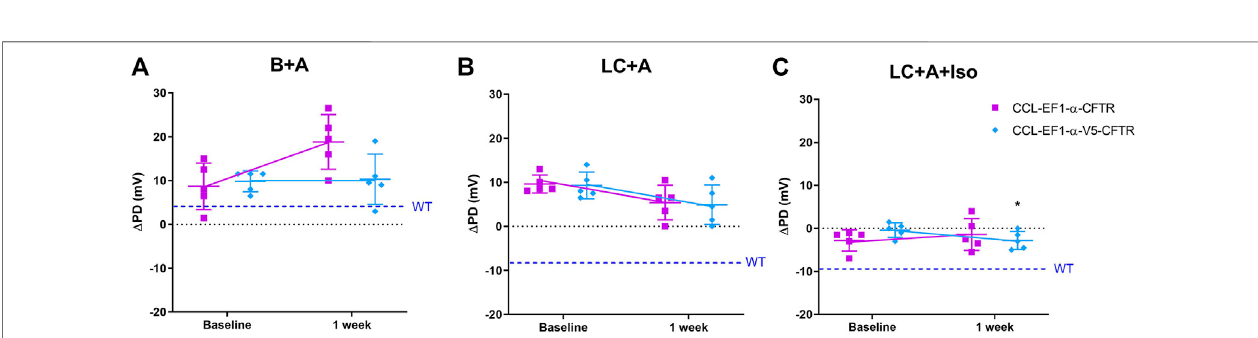
FIGURE 5 | Electrophysiological responses ( Δ PD) in CF mice before (baseline) and 1 week after delivery of a third generation CCL- CFTR (purple square), or CCL- CFTR withV5tag(lightbluediamond)vectors.Geneadditiontonasalairwaysfollowing (A) Basal+Amiloride(B+A), (B) Lowchlorideunderamiloride(LC+A)and (C) LC+A and isoproterenol(Iso)inKRB atthe 20 μ l/min infusionrate(* p < 0.05, Mean ± SD, pairedt-testvsbaseline, n (cid:2) 5;n.s.,unpairedt-test, CCL- CFTR vsCCL-V5- CFTR , n (cid:2) 5). The Δ PD wildtype level (WT) designated by dashed blue line.